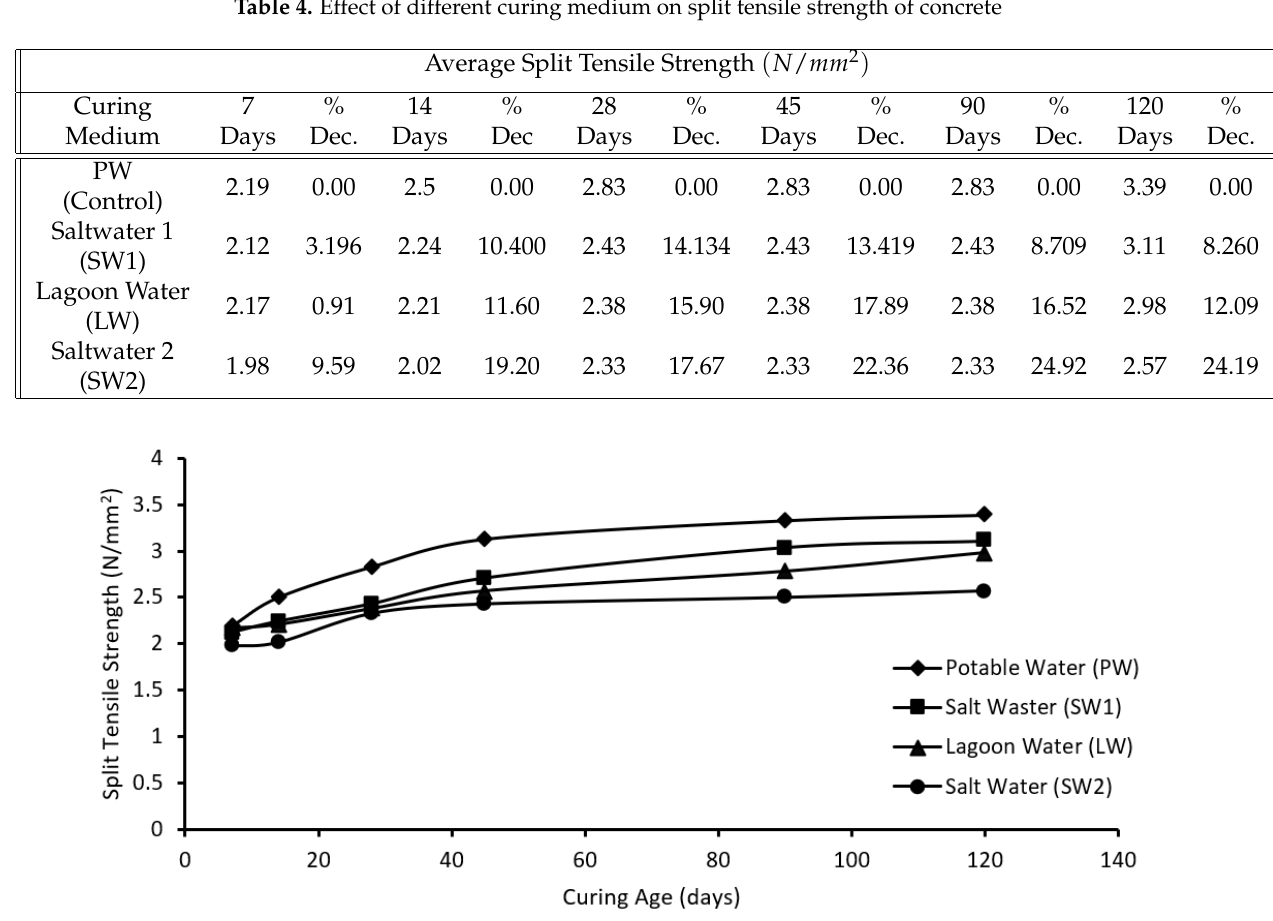
Figure 4. Effect of different curing medium on the split tensile strength of concrete